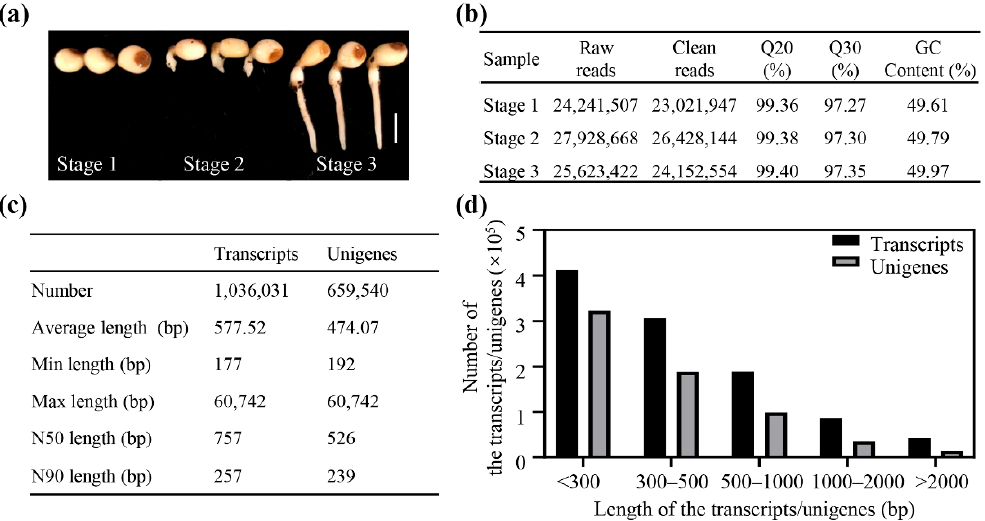
Figure 1. Summary of the transcriptome sequencing. ( a ) Seeds were harvested at three germination stages for RNA-seq. Bar is 0.5 cm. ( b ) Summary data of RNA-seq. ( c ) Number and length of the transcripts and unigenes. ( d ) Distributions of the transcripts and unigenes.